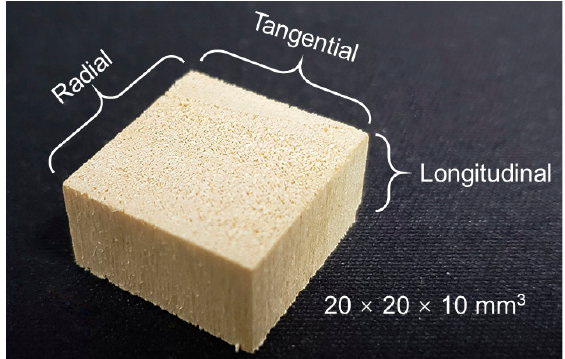
Figure 1. Photograph of a poplar sample. The sample size was 20 (tangential) × 20 (radial) × 10 (longitudinal) mm 3